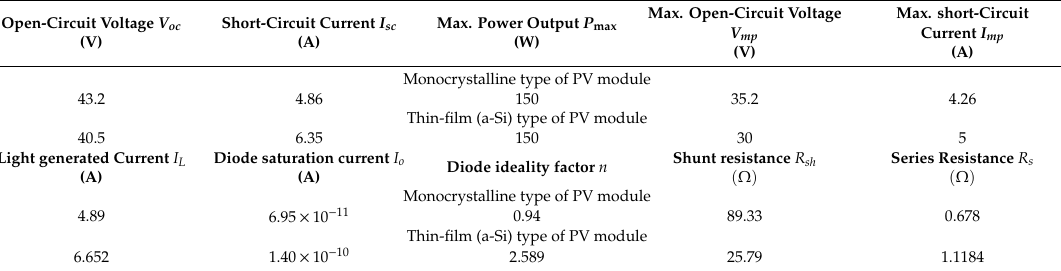
Table 3. Parameters of the considered PV